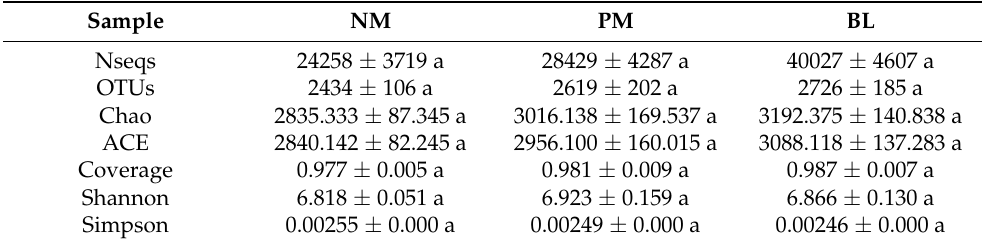
Table 1. The diversity indices of the soil bacterial community in a dryland field under three different